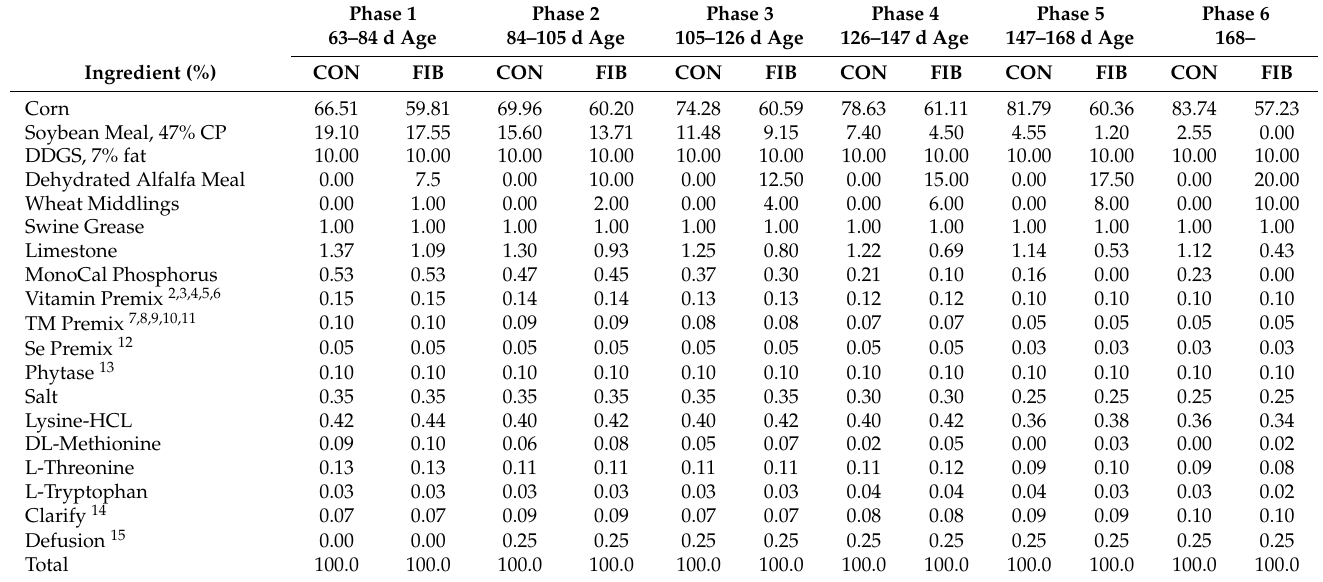
Table A1. Diet formulations for Large Black and Duroc-sired pigs fed control (CON) and fiber (FIB) diets 1